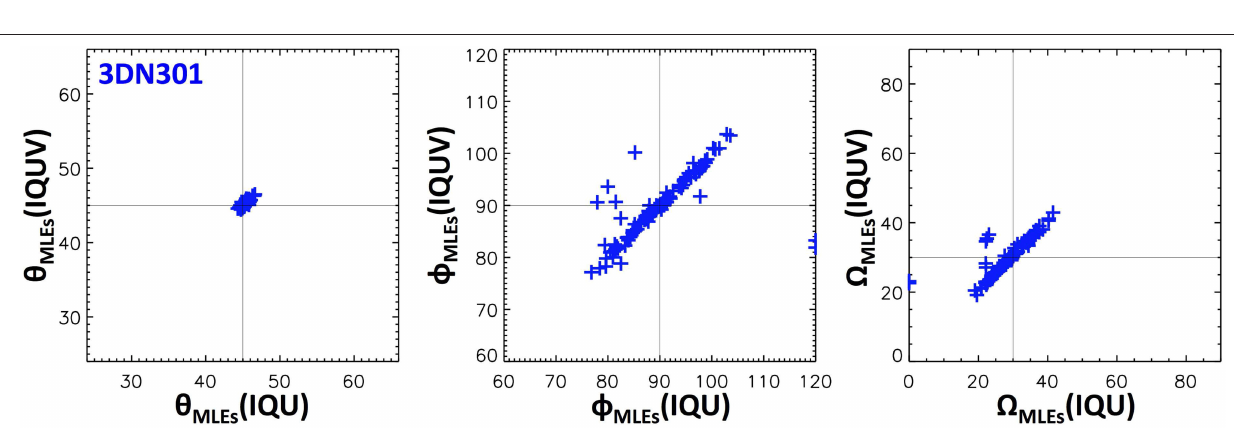
FIGURE 7 | Scatter plots showing the effect of using the circular polarization signal on the MLEs for the 3DN301 case. The thin black solid lines indicate the value of the ground